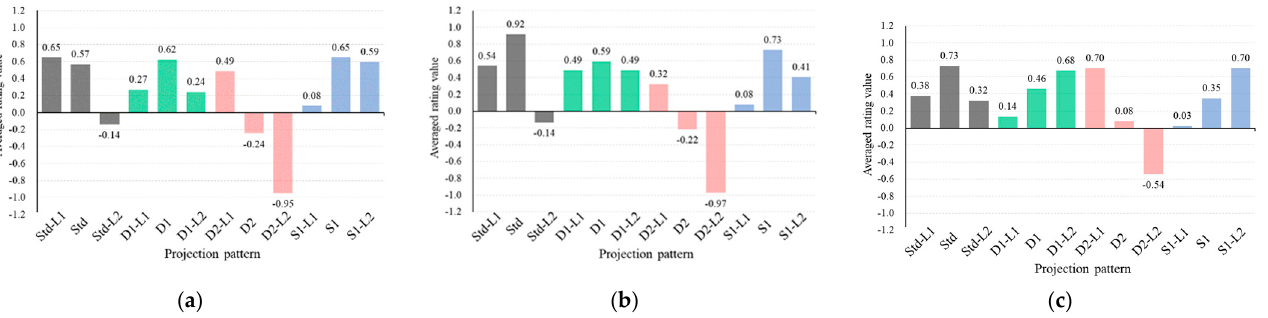
Figure 4. Evaluation results for all observers for each projection pattern. ( a ) Faithfulness; ( b ) Preference; ( c ) Depth feeling.